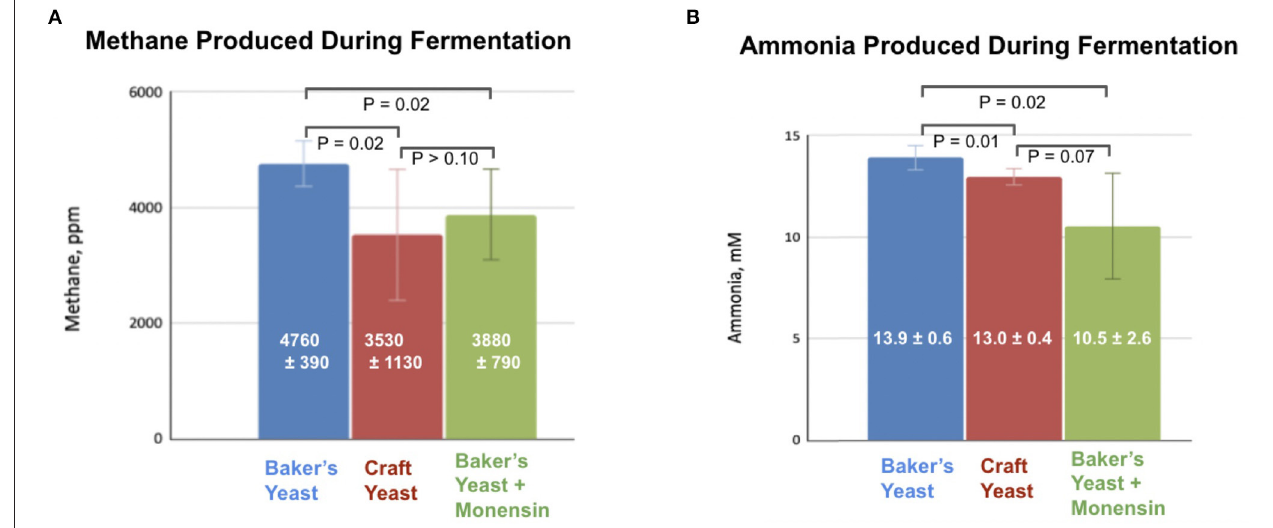
FIGURE 3 | Addition of monensin or switching to hop-rich craft brewer’s yeast inhibits production of (A) methane and (B) ammonia during anaerobic fermentation of a silage/corn substrate and a yeast supplement.